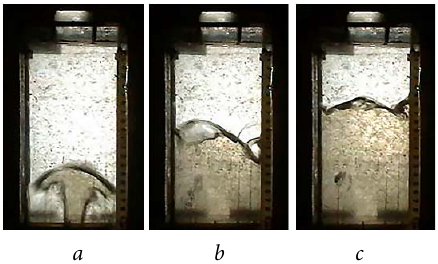
Fig. 3. Video frames of model cavity filling with a vacuum of 0.025 kg/cm 2 : a – initial stage; b – jet destruction stage;